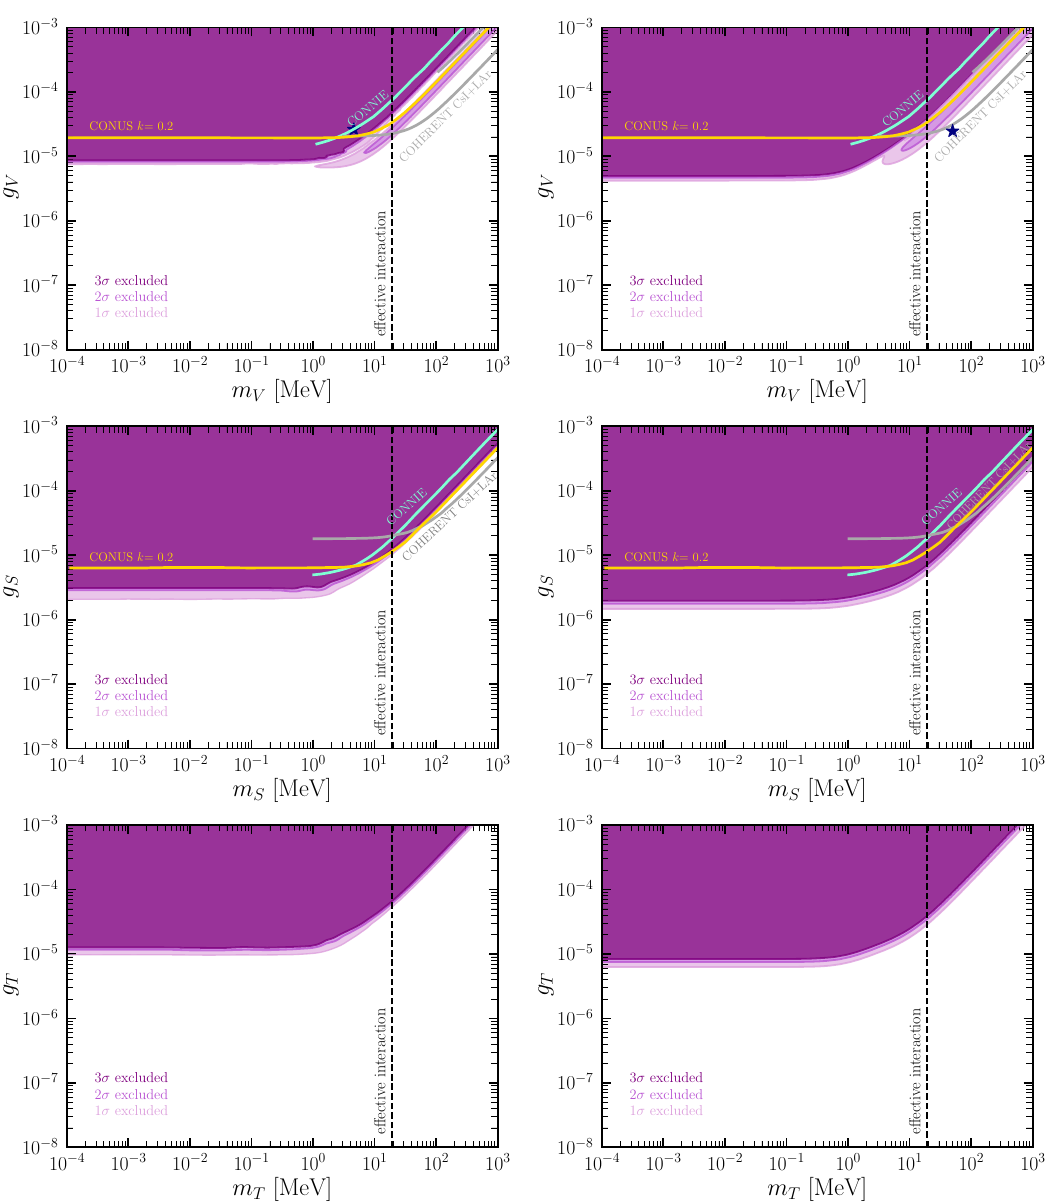
Figure 4 . Constraints on vector NGI (upper row), scalar NGI (central row) and tensor NGI (lower row) in the coupling-mass plane, obtained using the modified Lindhard QF (left column) and the iron-filter QF (right column). In all panels, purple regions indicate exclusion limits. Where present, dark blue stars specify the best fit solutions. Moreover, constraints from CONUS [38], CONNIE [97] and COHERENT CsI+LAr [98] are shown for comparison. Additionally, the black dashed vertical line marks the transition from the light to the effective